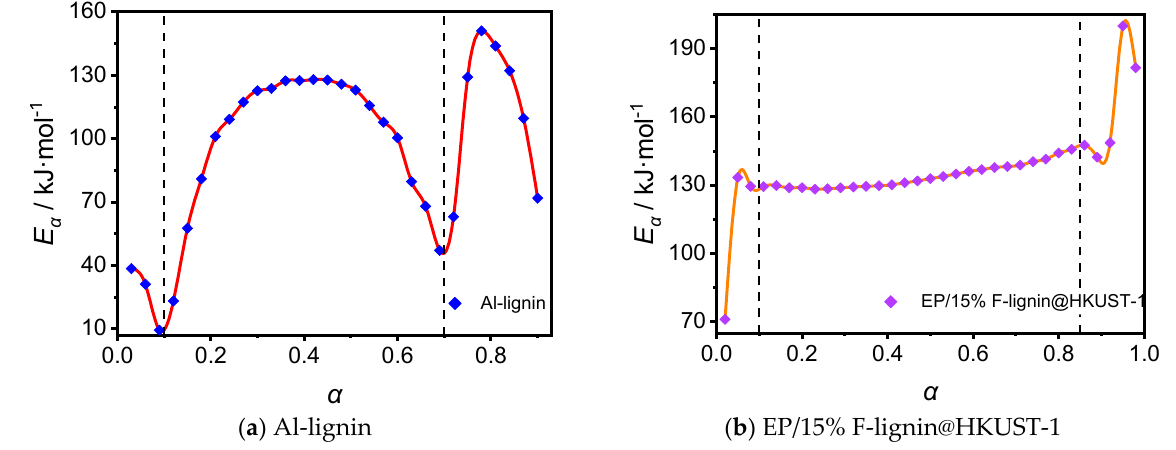
Figure 4. Relationship between activation energy and conversion of Al-lignin ( a ) and EP/15% F-lignin@HKUST-1.